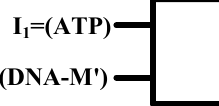
Figure 2. ( A ) Fluorescence emission spectra under different conditions: (a) DNA-T, DNA-M, and GO; (b) DNA-T, DNA-M, GO, and DNA-M’; (c) DNA-T, DNA-M, GO, and ATP; (d) DNA-T, DNA-M, GO, DNA-M’, and ATP. ( B ) Logical histogram.